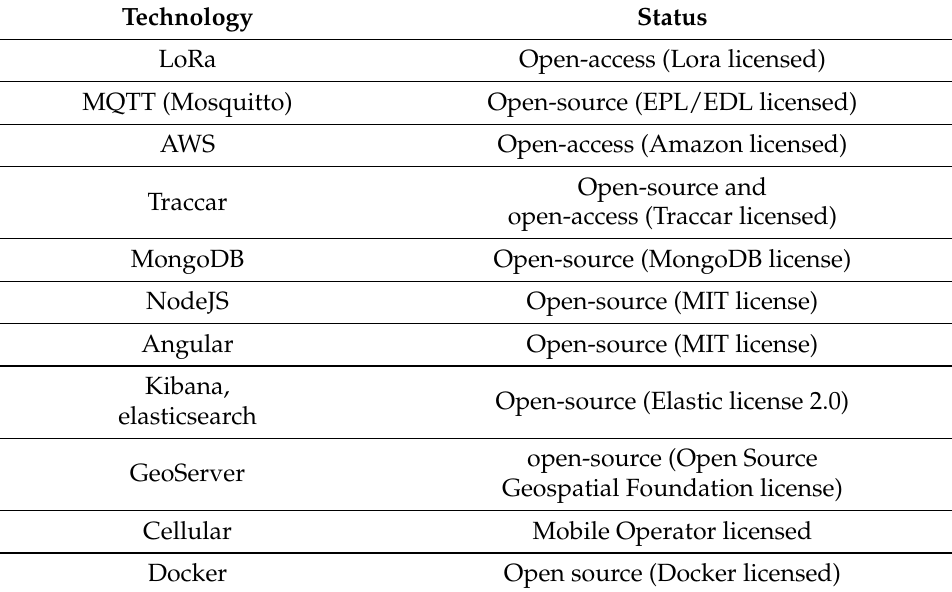
Table 1. Licensing/open-access/open-source status of the employed